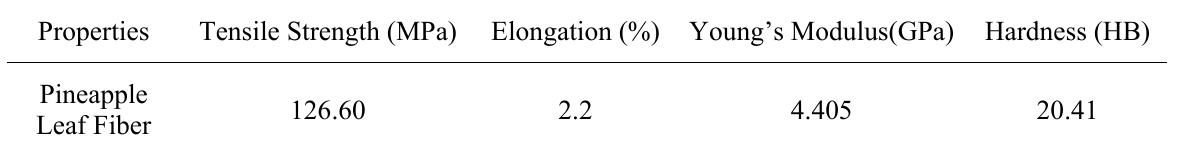
Table 2. Mechanical Properties of Pineapple Leaf Fiber